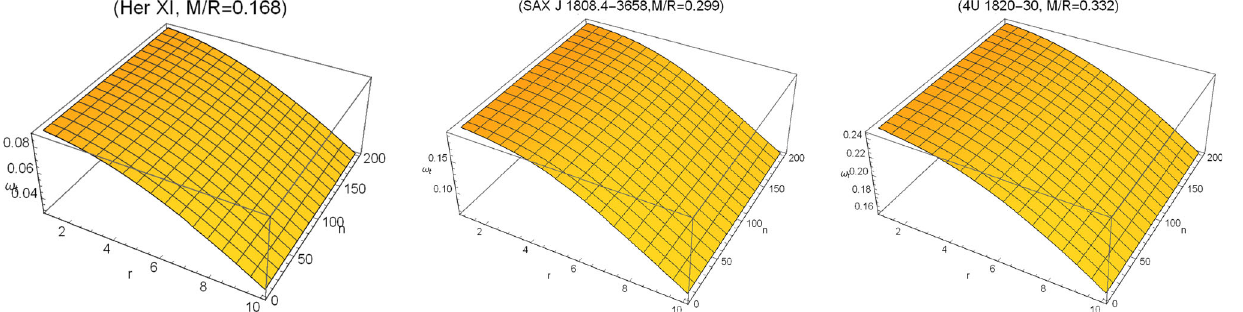
Fig. 2 Variation of EOS parameter ω t with radial coordinate r (km) and model parameter n